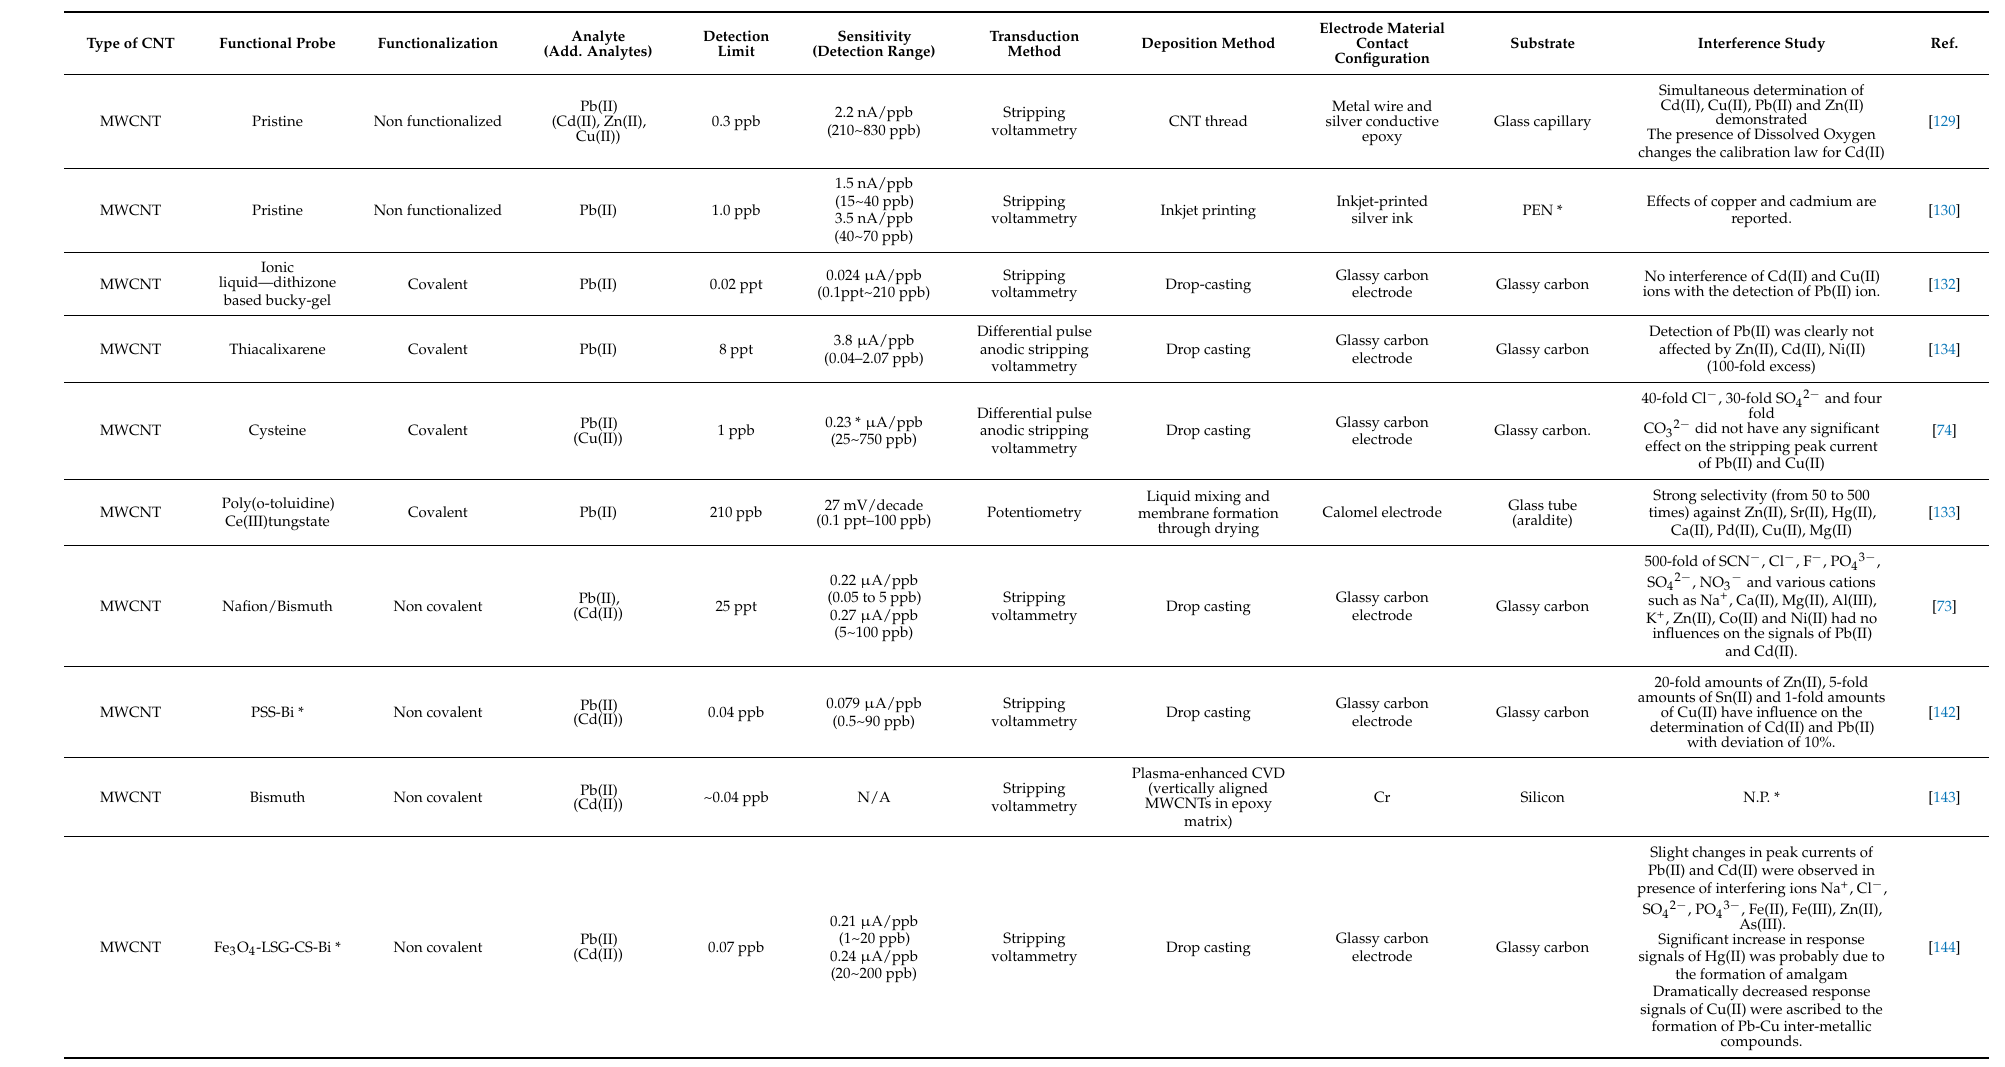
Table 3. CNT-based sensors for detecting (II)Pb(II) ions in water, sorted by type of functionalization then detection